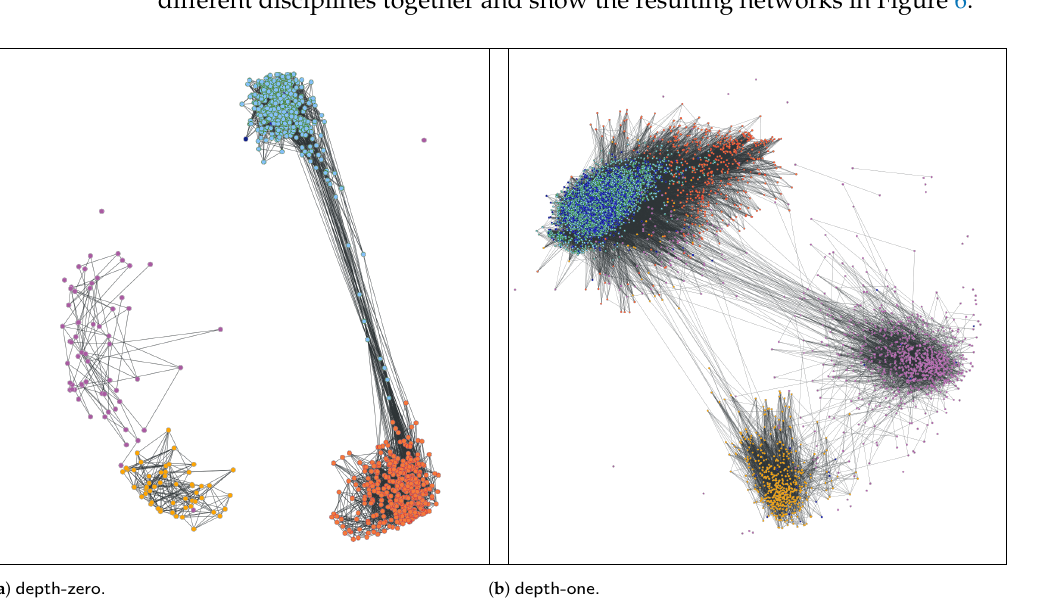
Figure 6. Co-authorship network of the four academic disciplines ( ING-INF/05 dark orange, INF/01 cyan, MAT/05 is orange, and SECS-P/01 is